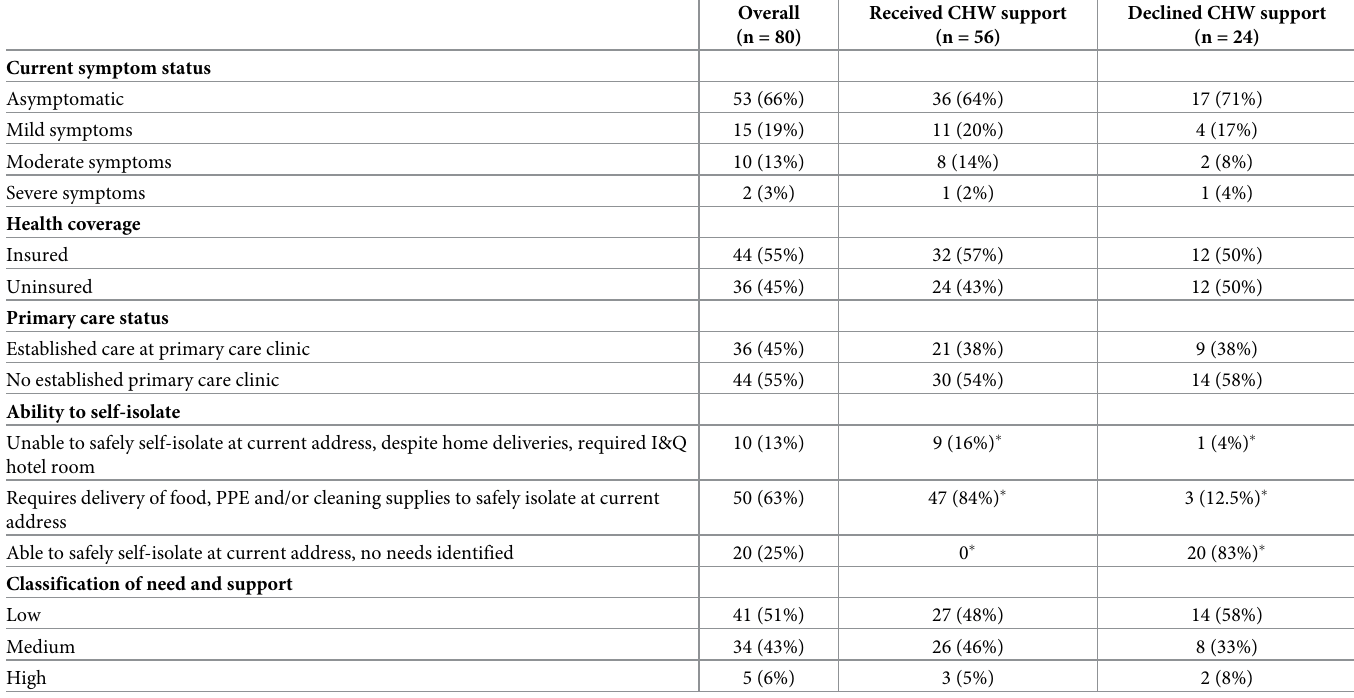
Table 4. Characteristics and needs of COVID-19 positive participants identified during initial needs